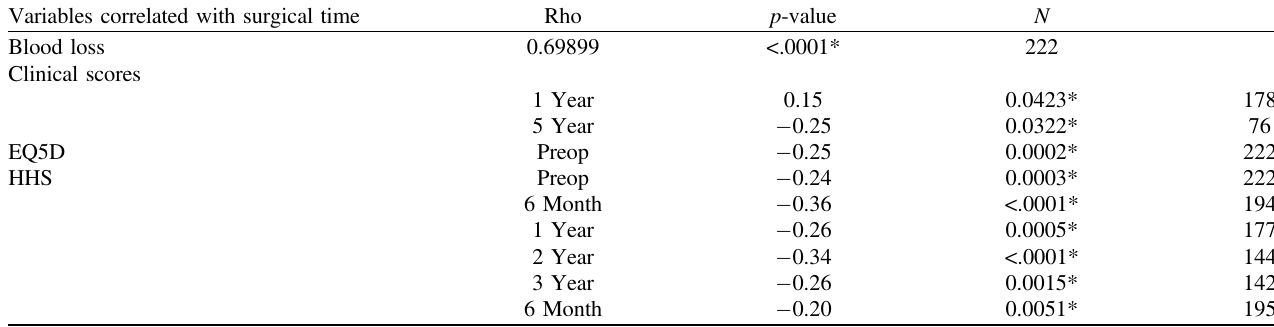
Table 5. Signi fi cant correlations between surgical time and blood loss, clinical scores, and laboratory values. Variables correlated with surgical time